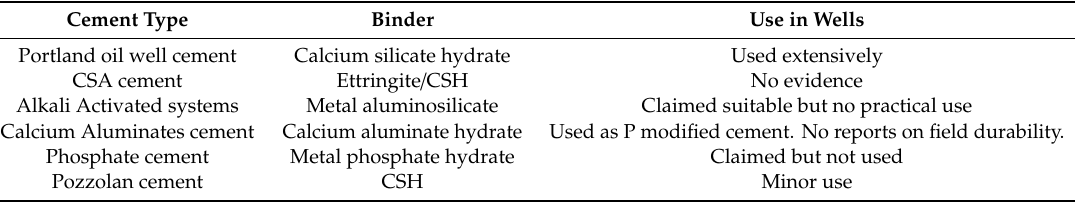
Table 1. Potential cementing